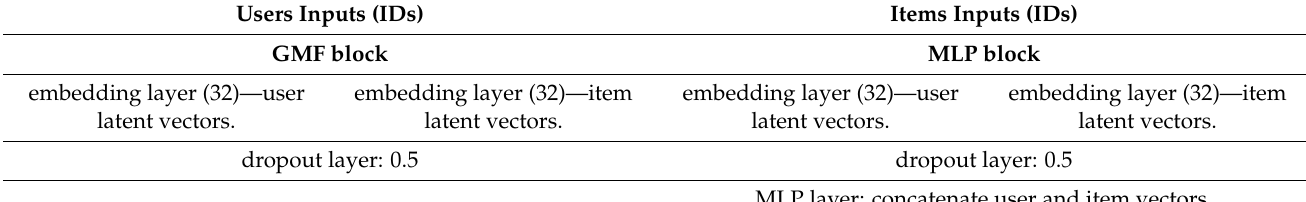
Table 5. Architecture of NNMF recommender engine.